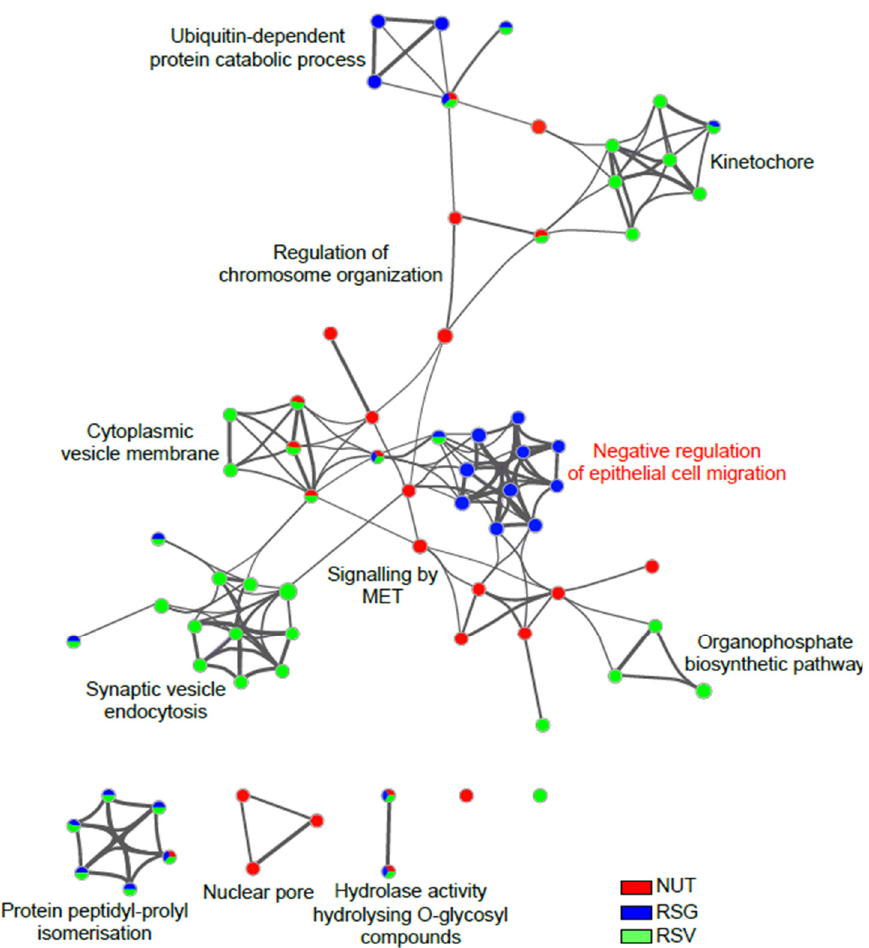
Figure 6. Network visualization of Gene Ontology (GO) molecular function clusters in differentially down-regulated proteins from lasered mice retina. Enriched terms in significantly down-regulated proteins in RSG, NUT, and RSV groups compared with the control diet group (Co) were selected and rendered as a network plot to further determine the relationship among terms, where terms with similarity of >0.3 were connected by edges. The network of enriched sets colored according to experimental group identity was visualized with Cytoscape (v3.1.2) with “force-directed” layout and with bundled edges. The size of a node is proportional to the number of input DEPs that fall into the term and slices within each node represents the number of proteins under the term that originate from each experimental diet group .